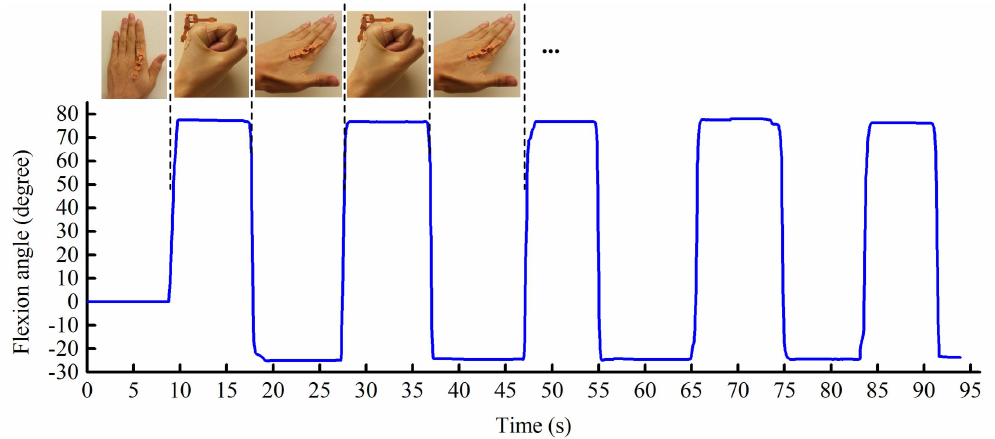
Figure 6. The repeated flexion and extension of the metacarpophalangeal joint of the participant’s left index